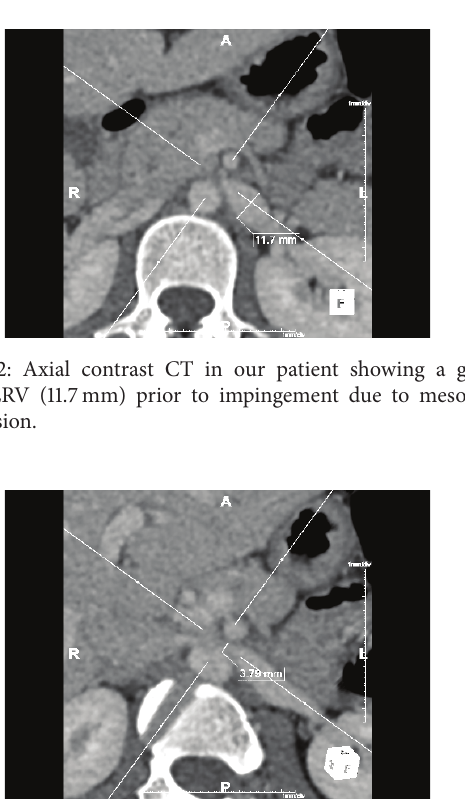
Figure 3: Axial contrast CT in our patient showing a LRV diameter of 3.79 mm due to mesoaortic compression. A reduction in diameter of ≥